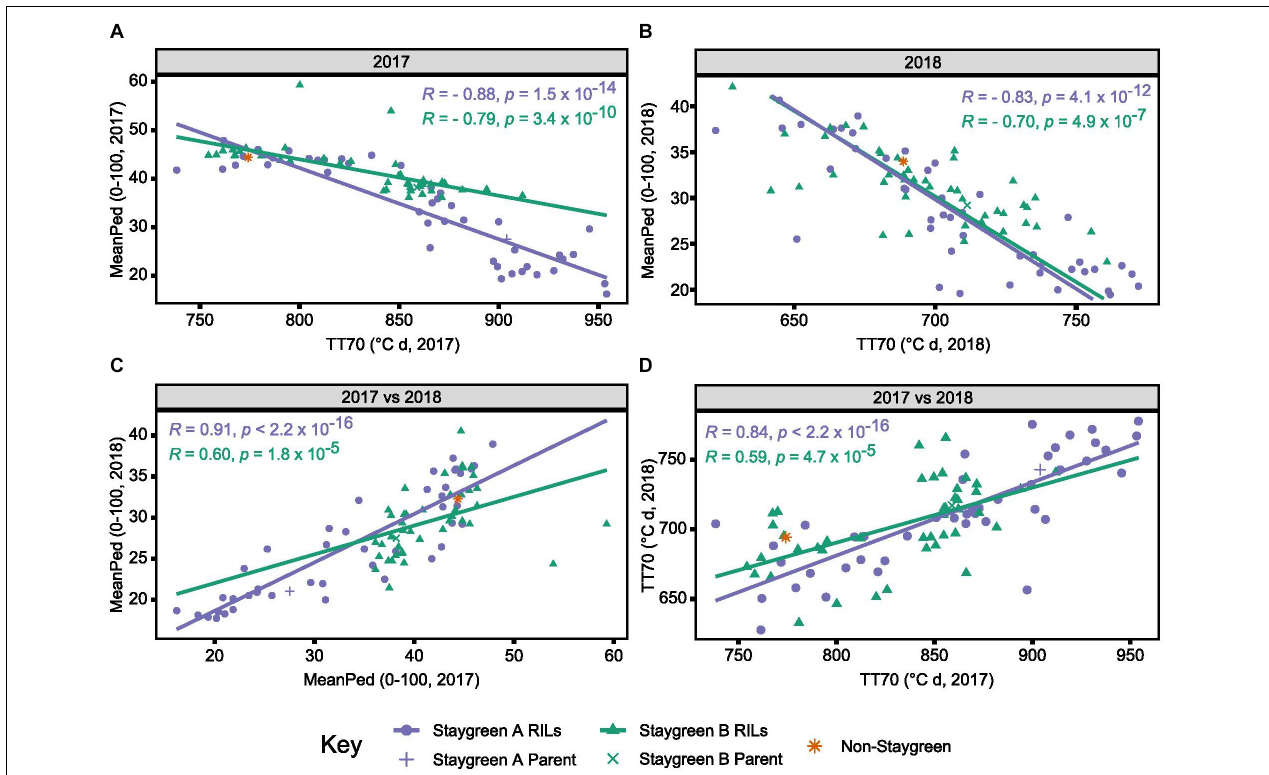
FIGURE 5 | Environmental stability and concordance of metrics TT70 and MeanPed aids in the discrimination of staygreen and non-staygreen types. Through comparing TT70 and MeanPed values recorded in 2017 (A) and 2018 (B) , one can distinguish senescence variation, whereby “staygreen” and “non-staygreen” lines cluster in the bottom-right and top-left corners, respectively. Between-year Spearman’s rank correlations for metrics MeanPed (C) and TT70 (D) range from R = 0.59 to 0.91, P < 0.0001, with the metrics themselves negatively correlated, R = 0.7 to 0.88, P < 0.0001 (A,B) . Spearman’s rank correlations calculated for the 36–42 RILs per population grown at Church Farm, Bawburgh, Norwich (JIC) between 2017 and 2018, plotting mean value per line, n ≥ 2. Staygreen A parent and RILs (purple), staygreen B parent and RILs (green), and recurrent parent